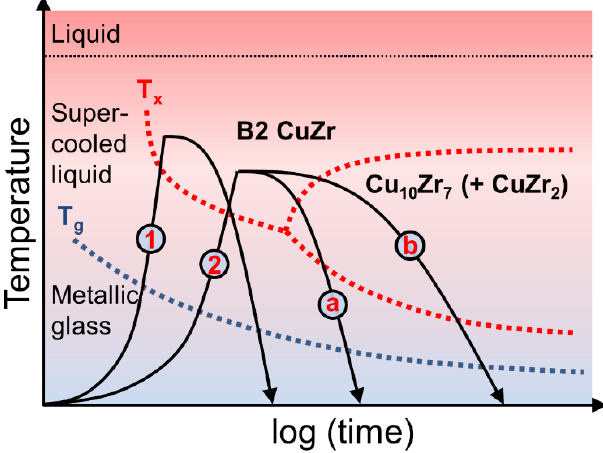
Figure 1. Schematic continuous heating transformation (CHT) diagram of the Cu 47.5 Zr 47.5 Al 5 metallic glass based on [20].